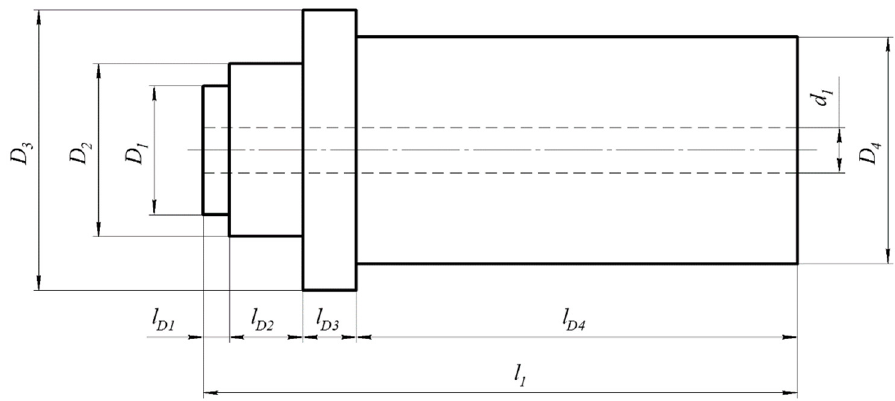
Figure 1. Configuration and geometry dimensions of the spindle .